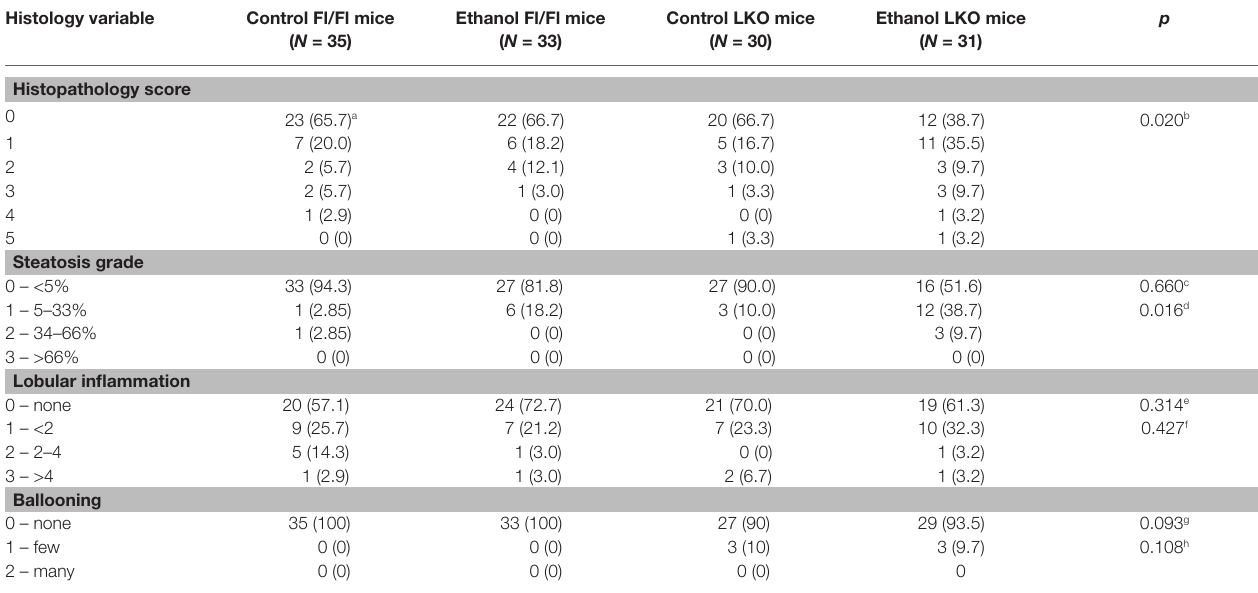
TABLE 1 | Statistical analyses of liver histopathology scores. Histology